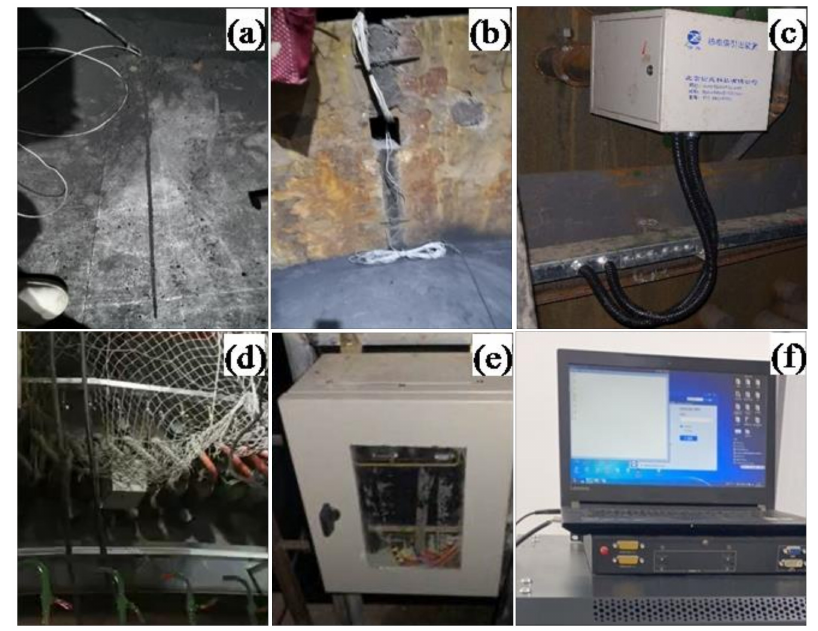
Figure 5. EMF measurement system on the blast furnace hearth: ( a ) EMF sensor, ( b ) compensation wire, ( c ) junction box, ( d ) wiring bridge ( e ) signal conversion box, and ( f ) display device.